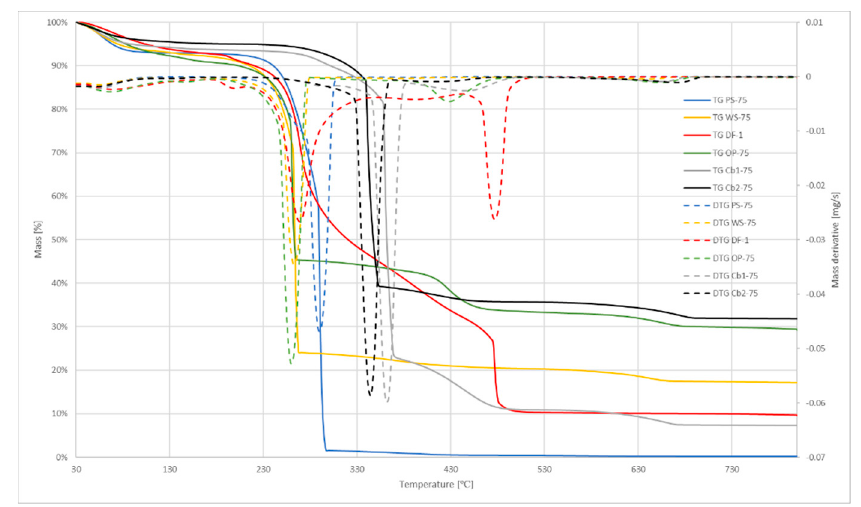
Figure 3. Oxygen atmosphere TG and DTG curves.